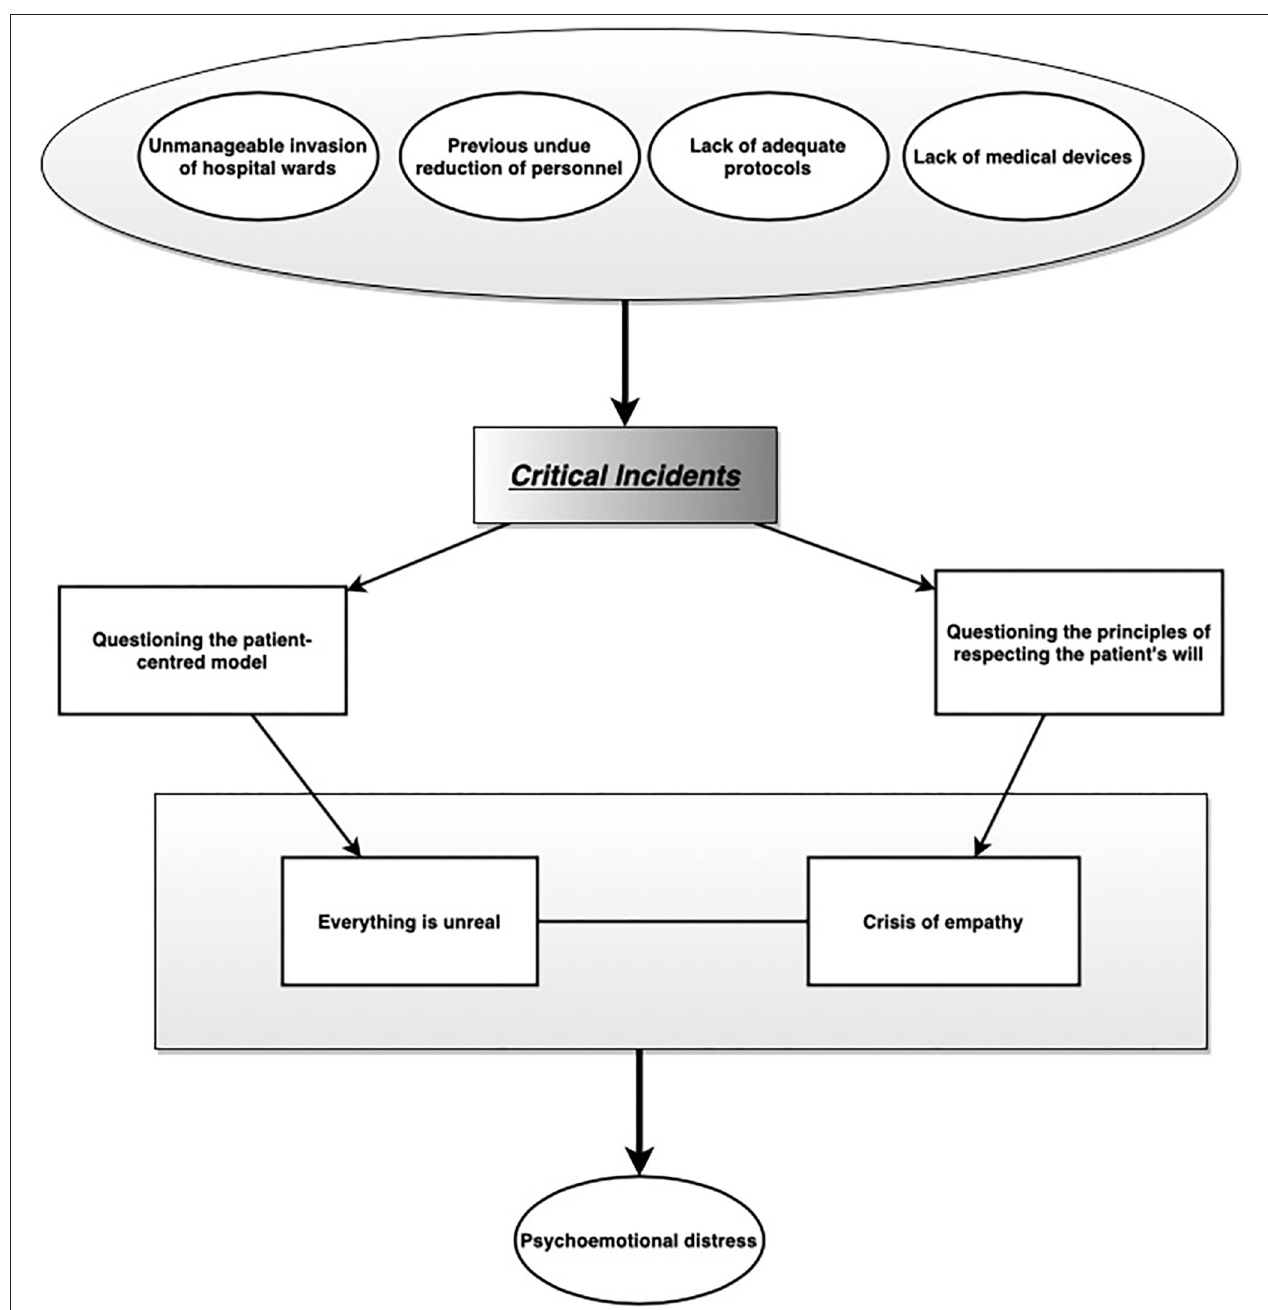
FIGURE 1 | Findings of qualitative data analysis. Main themes and their